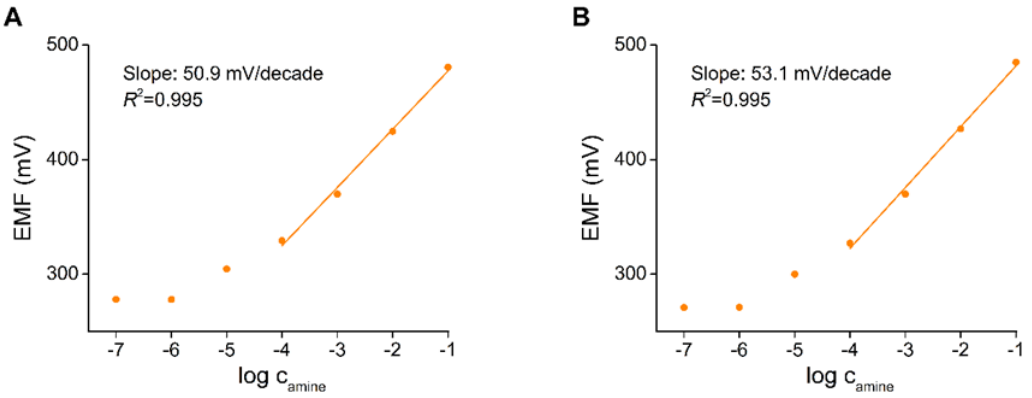
Figure 12. Calibration curves of the membrane electrodes containing the crown ether ( R , R )- 1 ( A ) or ( R , R )- 2 ( B ) as an ionophore with the hydrochloride salt of racemic NEA ( 21 ).